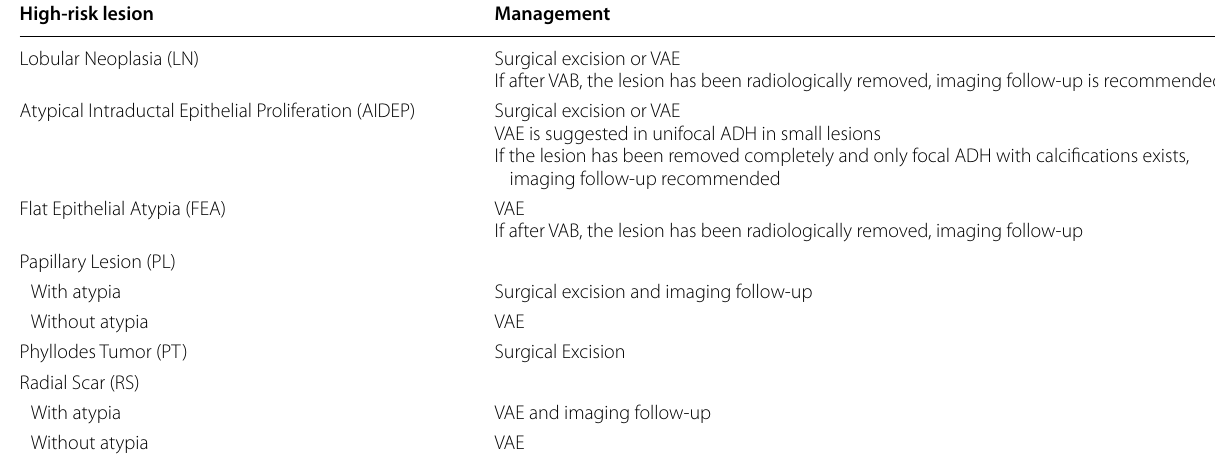
Table 1 Consensus recommendations for the management of B3